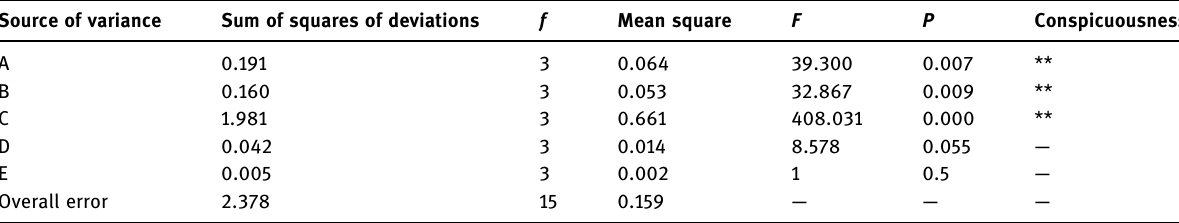
Table 8: Variance analysis of the cutting speed Source of